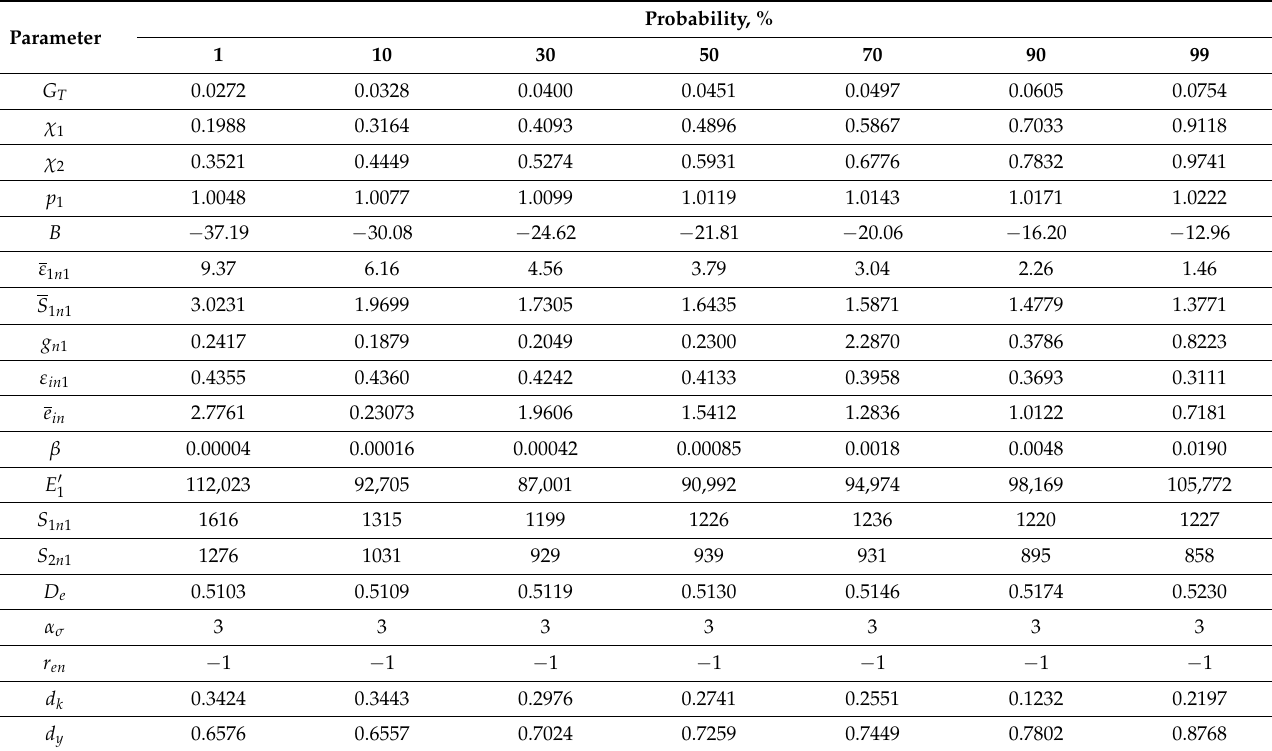
Table A6. Calculation data in the concentration zone for failure probabilities 1%, 10%, 30%,50%, 70%, 90%,